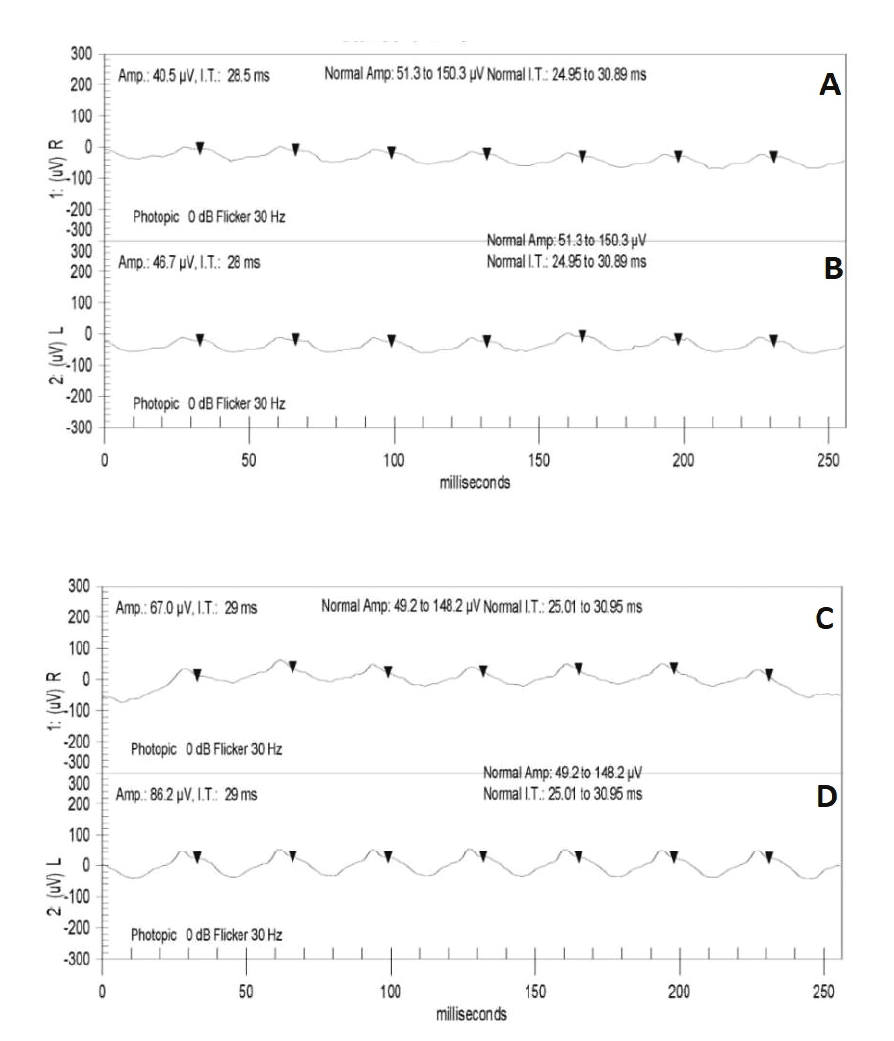
Figure 4. 30-Hz flicker electroretinography (ERG) of the right (A) and left (B) eyes before starting treatment and the right (C) and left (D) eyes 12 months after treatment. They show improvement in 30-Hz flicker amplitude and stability in 30-Hz flicker implicit time in both